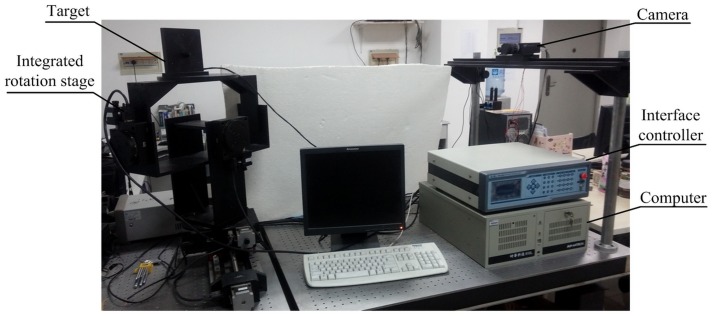
Experiment devices.